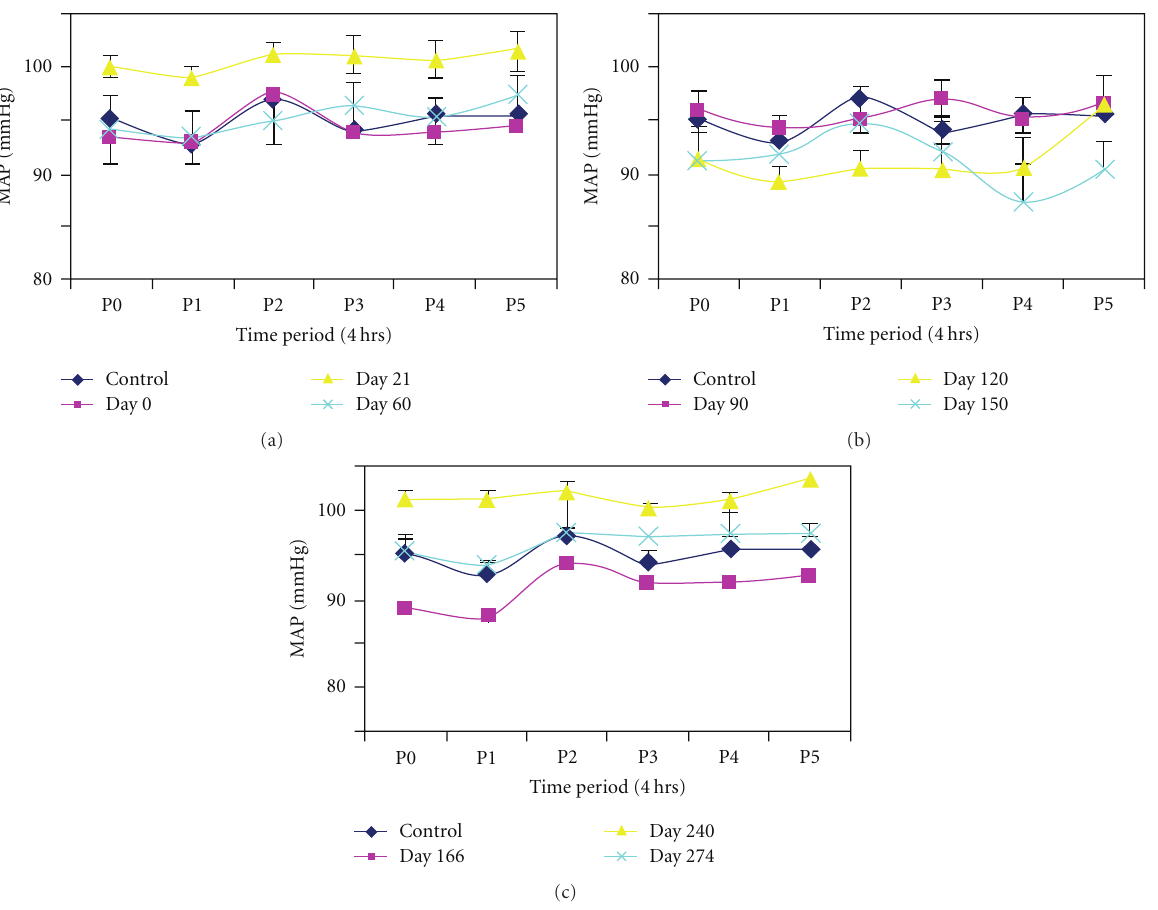
Figure 2: Circadian variations in blood pressure in six diurnal periods (P0–P5) at (a) 0, 21, 60 days, (b) 90–150 days, (c) 166–274 days of diabetes duration. Values are mean ±